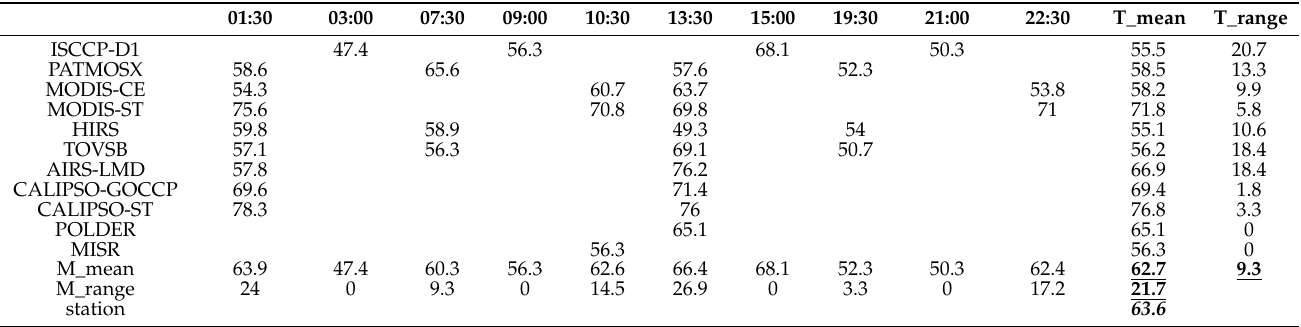
Table 3. Total cloud amount across the different observation times (local time) and different datasets in winter over south China (unit: %). M_mean is the mean cloud amount averaged over all datasets at each specific observation time; M_range is the TCA range for all satellite datasets; T_mean is the mean cloud amount averaged over all observation times for each satellite dataset; and T_range is the TCA range among different observation times. Bold value with an underscore is the mean value averaged over 11 satellite datasets at all observation times, and bold and italic value is for station